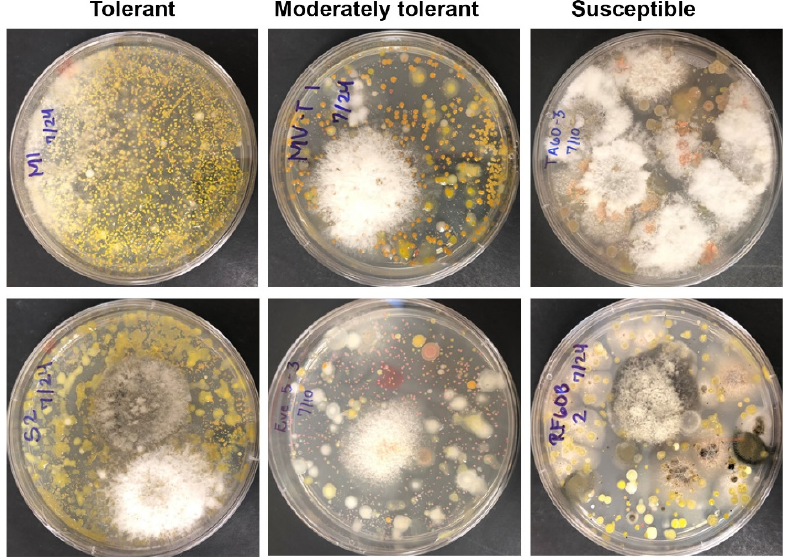
Figure 2. Diverse bacterial and fungal endophytes on potato dextrose agar media spread with the preparation of boxwood leaves with different levels of blight tolerance and incubation at 23 °C. Pictures were taken 10 and 14 days after the inoculation.